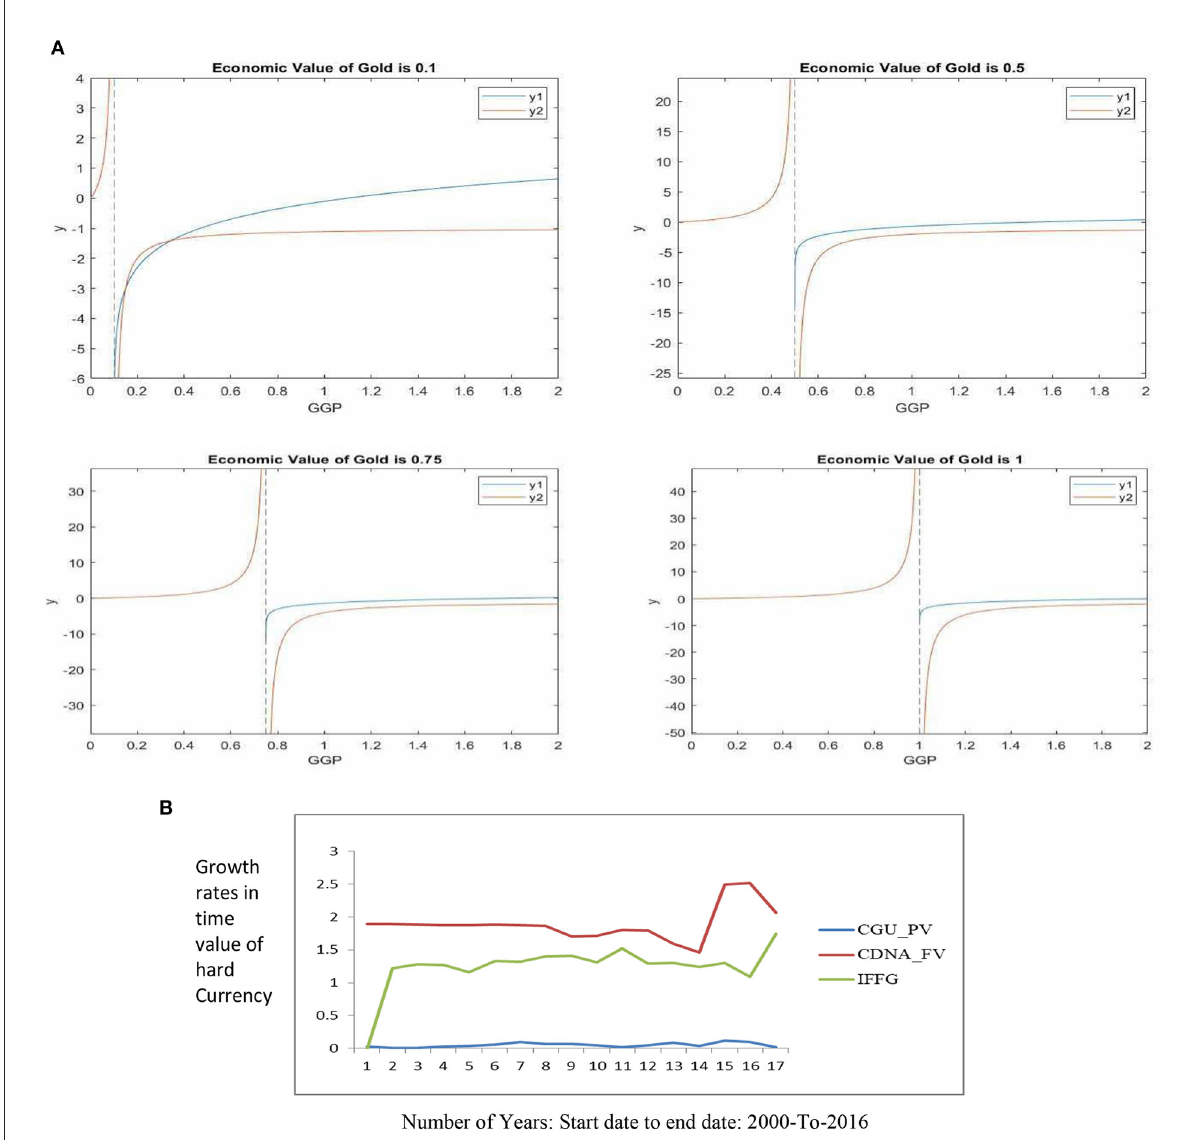
FIGURE1 (A) Critical Points Graph of the IFFG of the OPREM model. (B) Plot of the OPREM Component series (Reserve component